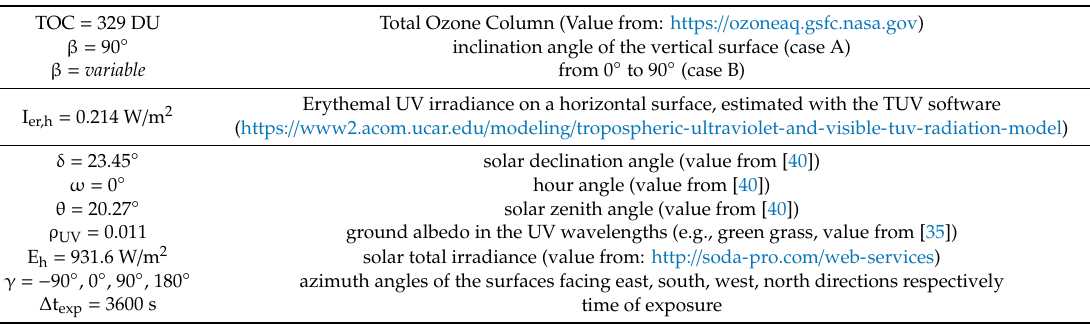
Table 2. Required input data for the numerical